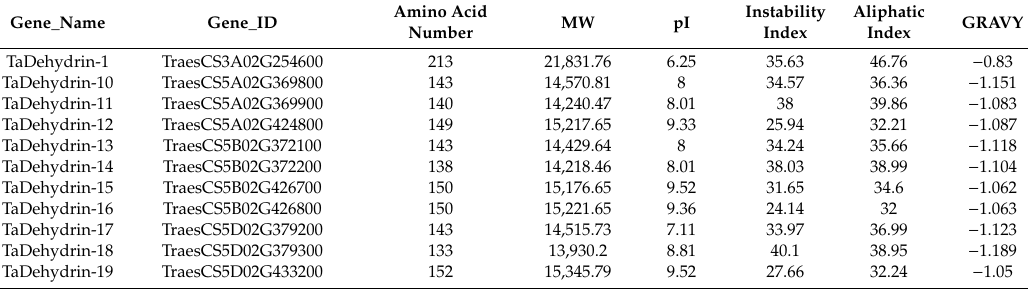
Table 1. Description of Late Embryogenesis Abundant ( LEA ) genes identified from the wheat